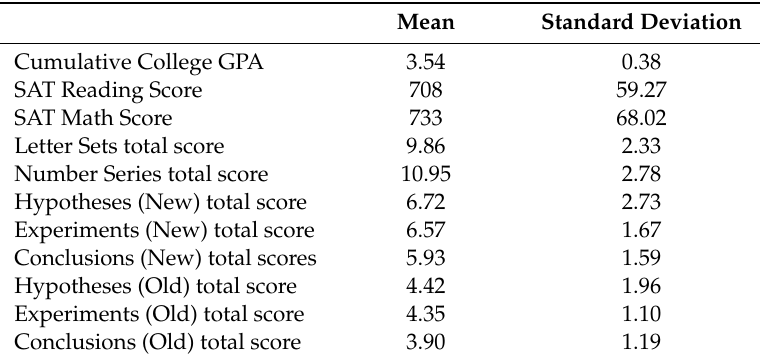
Table 1. Study 1 mean scores and standard